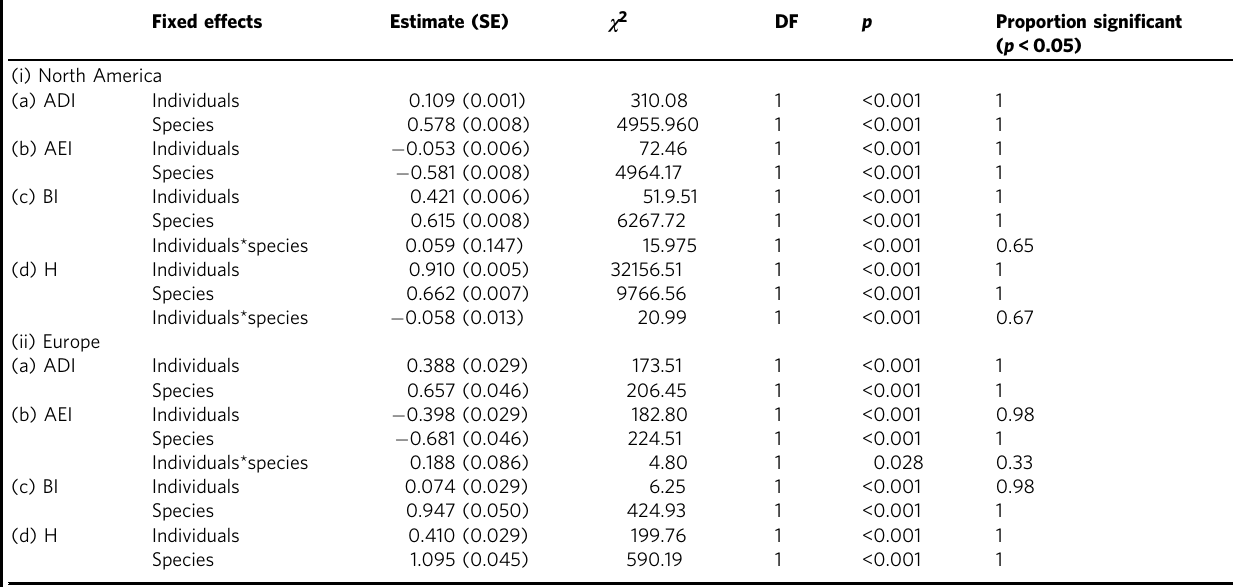
Table 4 Results of GLMMs of the association between site-level trends in acoustic indices and site-level trends in the total number of individuals and species in (i) 202737 NA-BBS sites across North America between 1996 and 2017 and (ii) 16524 PECBMS sites across Europe between 1998 and 2018, and the proportion of 1000 bootstrapped models reporting signi fi cant effects for each term ( p <